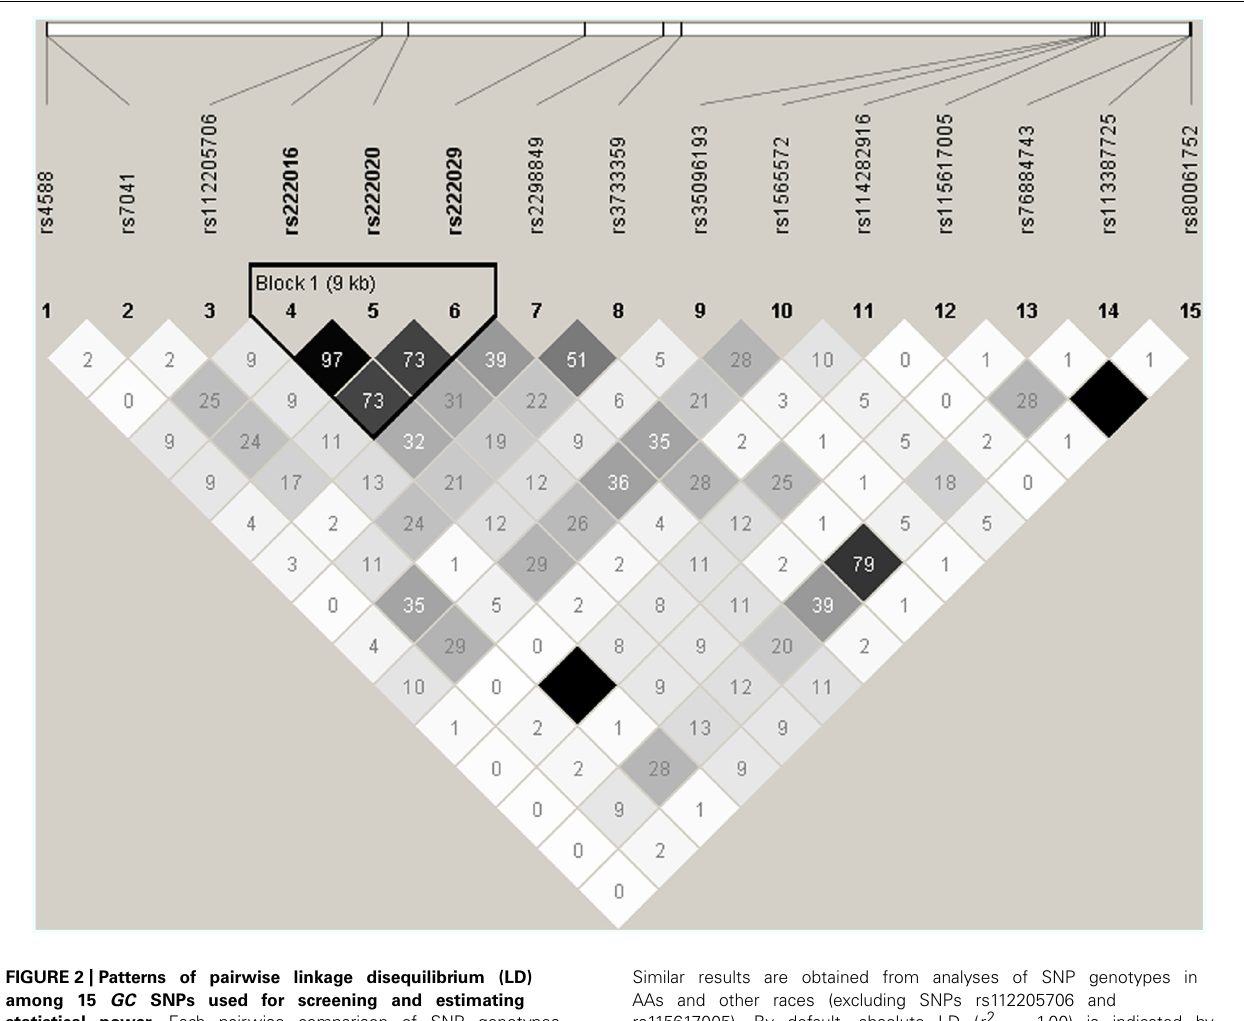
Similar results are obtained from analyses of SNP genotypes in AAs and other races (excluding SNPs rs112205706 and rs115617005). By default, absolute LD ( r 2 = 1.00) is indicated by a dark